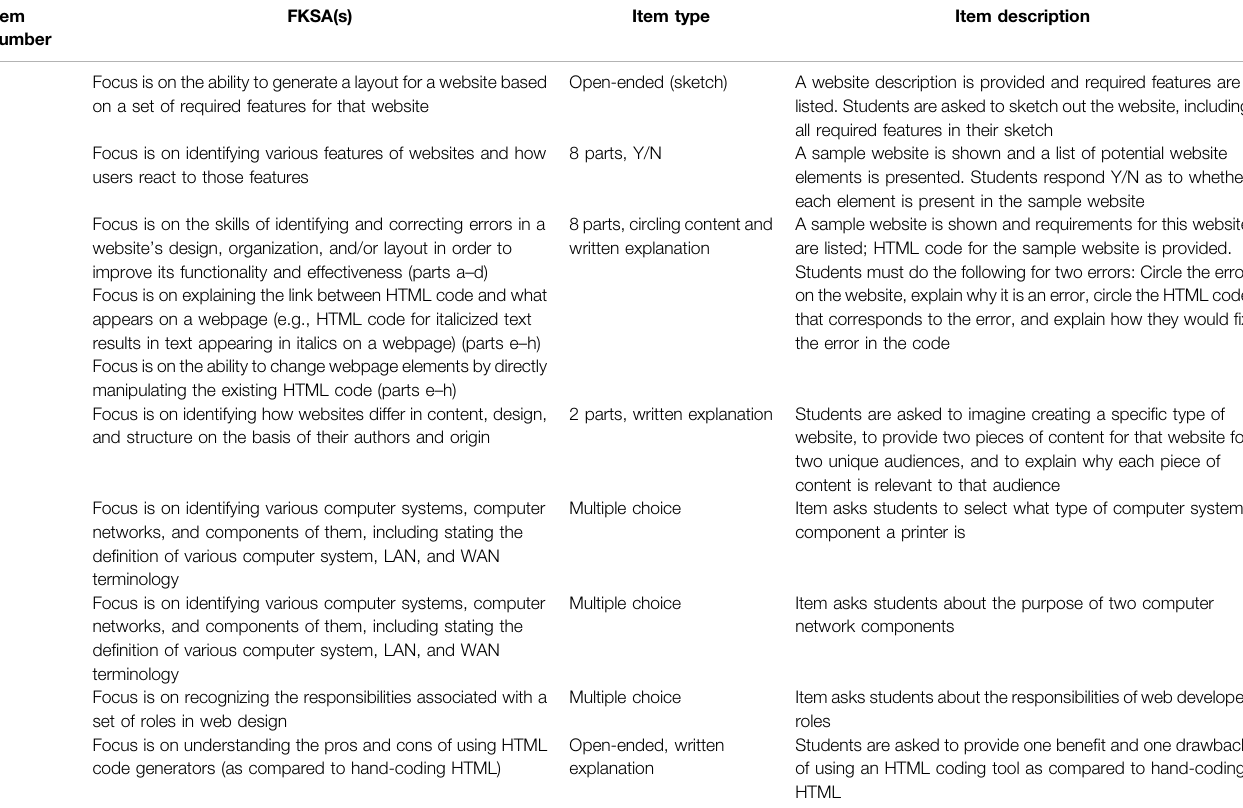
TABLE 3 | Overview of unit 2 assessment